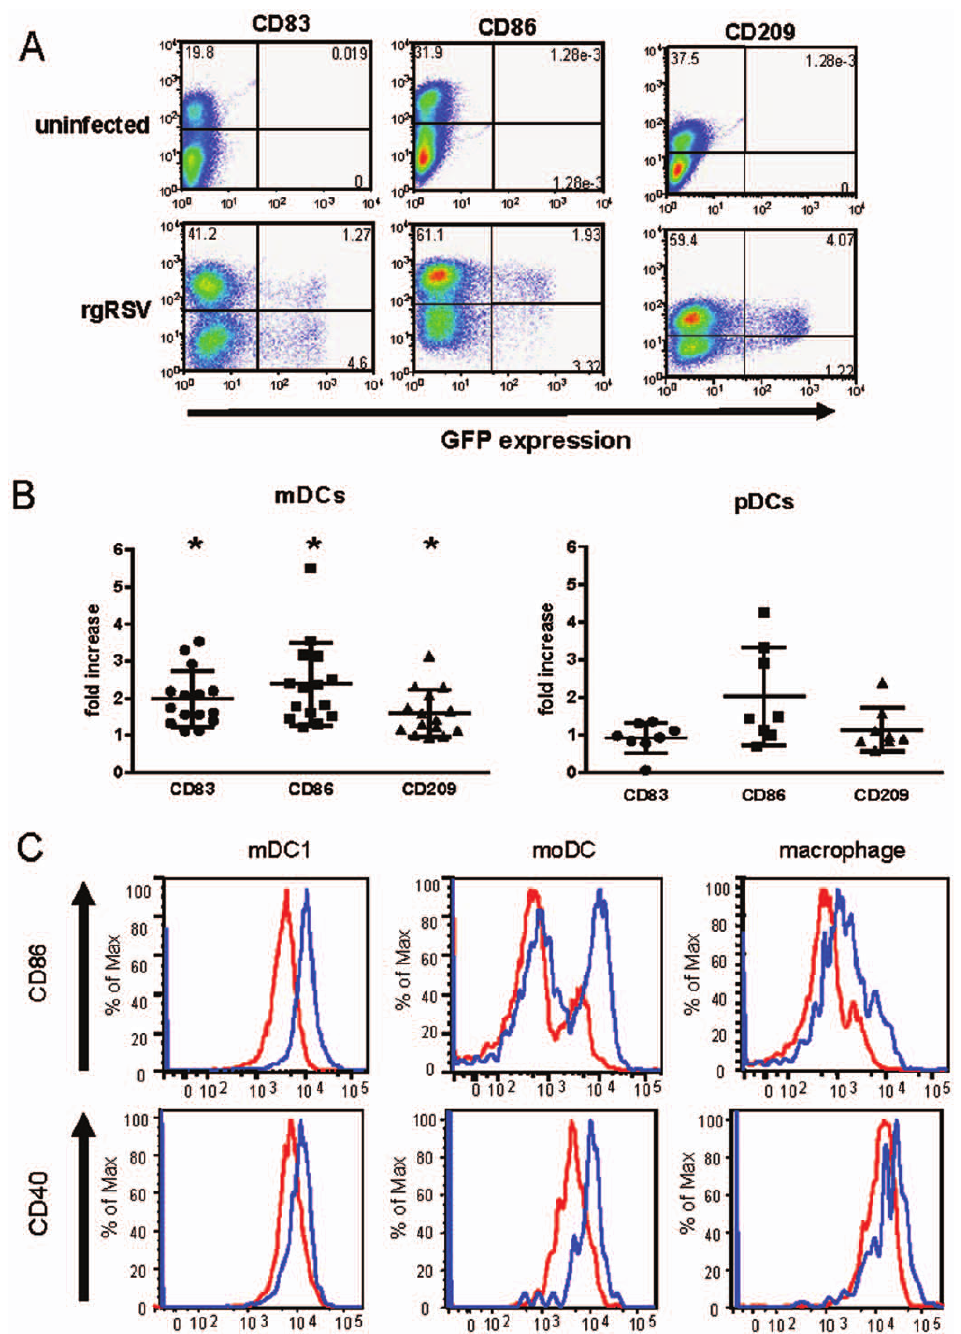
Figure 2. RSV infection and maturation of primary mDC1 and pDCs and of moDCs and macrophages. From elutriated monocytes of a single donor, primary mDC1 and pDC were isolated and moDC and macrophages were generated as detailed in the Materials and Methods. PanelA – Isolated mDC1 (shown above) and pDC (not shown here) were infected with rgRSV (moi=5). RSV infection (GFP expression) and DC maturation (CD83, CD86, and CD209 expression) were evaluated after overnight incubation with rgRSV. Dot plot results for mDC1 from a single representative donor (of 15) are shown above. PanelB – mDC1 and pDCs were exposed to live RSV, and DC maturation was examined 18–24 hrs later. Expression of each maturation marker in mDC1 and pDCs is shown, normalizing the mean fluorescence intensity (MFI) in RSV-exposed DC cultures to mock- infected DCs for the same donor. N=16 for mDC1 and 8 for pDCs. PanelC – After overnight exposure of primary mDC1, moDC, and macrophages from a single donor to live rgRSV, DC maturation was examined by flow cytometric analyses of CD86 and CD40 expression. A representative maturation profile is shown with similar maturation patterns observed in 5 independent donors.